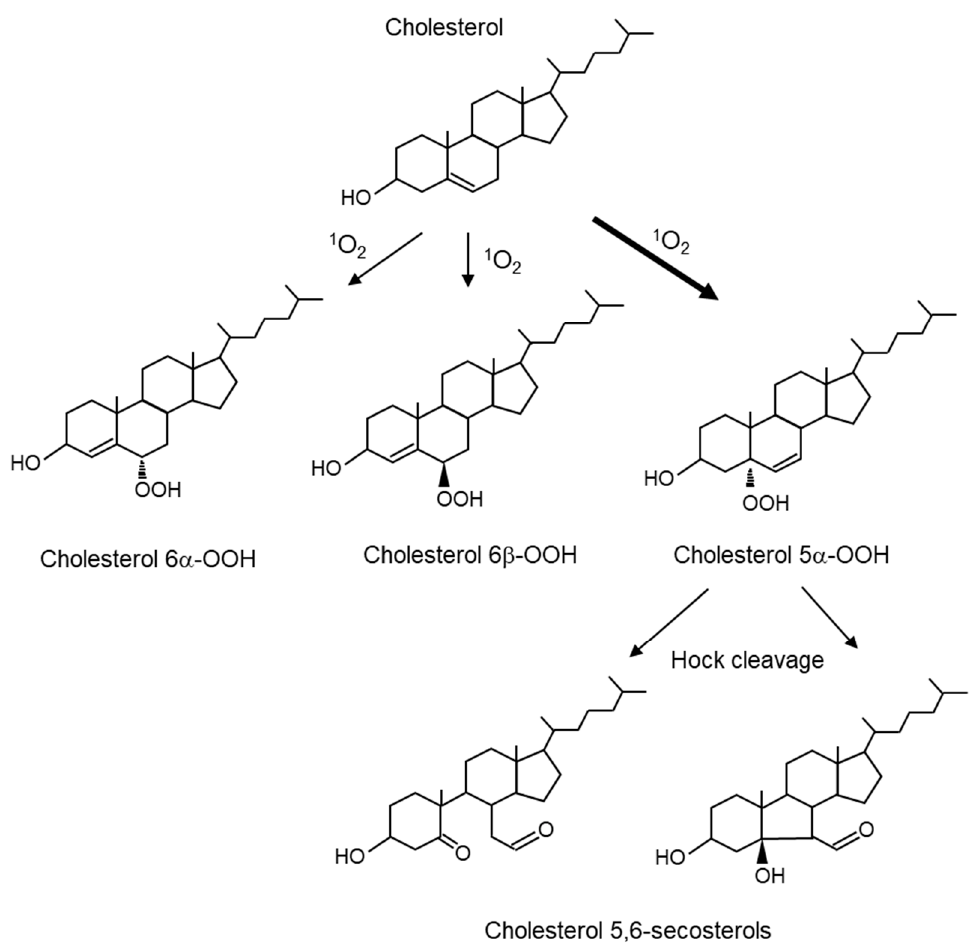
Figure 6. Structures of cholesterol peroxides produced by 1 O 2 -mediated oxidation reactions. 1 O 2 oxidizes cholesterol to produce 5 α -hydroperoxide (cholesterol 5 α -OOH), 6 α -hydroperoxide (choles- terol 6 α -OOH), and 6 β -hydroperoxide (cholesterol 6 β -OOH). Hock cleavage of cholesterol 5 α -OOH converts it to cholesterol 5,6-secosterols.